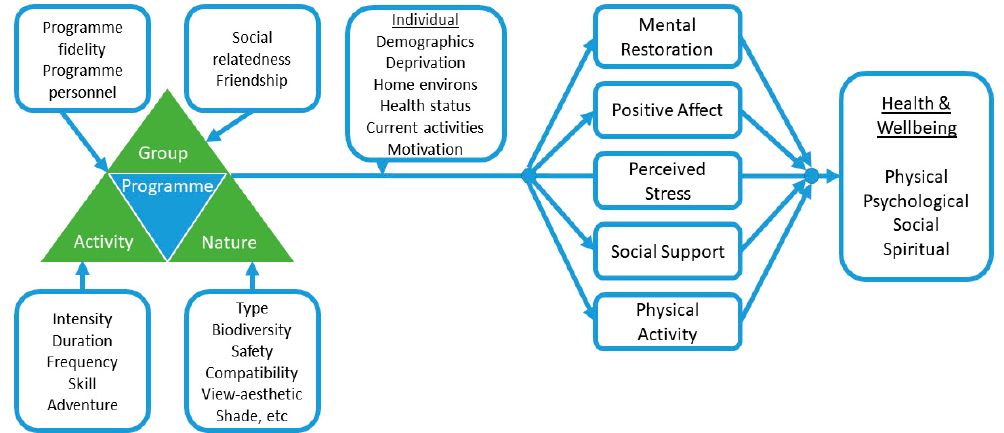
Figure 4. Conceptual model for investigating nature-based interventions that aim to promote health and wellbeing through behaviour change. The model illustrates components of the intervention, possible moderators, mediators and downstream health and wellbeing outcomes. Drawn from [23,37,41,82–84].